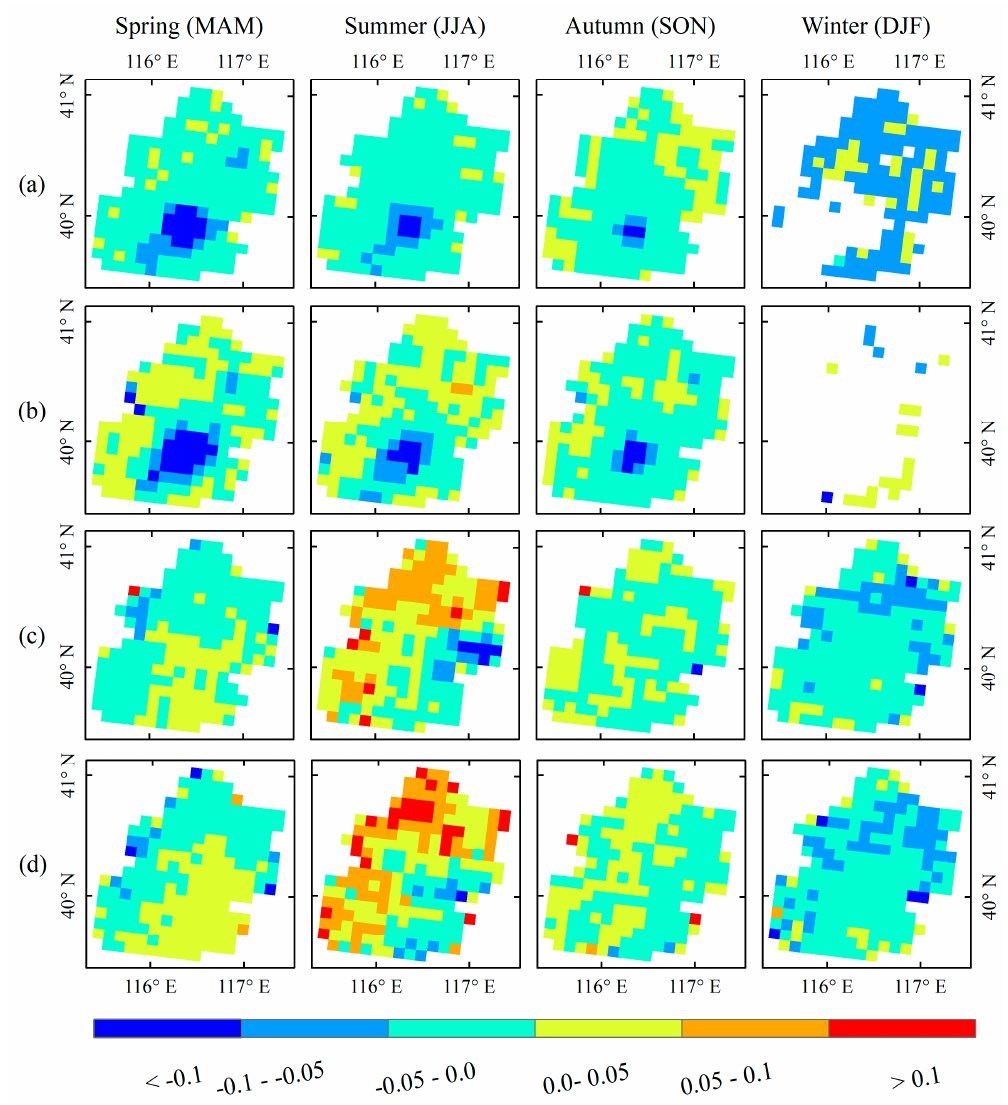
Figure 7. Seasonal mean differences ( δ AER , defined as C6.1_AOD–C6_AOD) of ( a ) MODIS-Terra (MOD04) DT, ( b ) MODIS-Aqua (MYD04) DT, ( c ) MOD04 DB, and ( d ) MYD04 DB AOD retrievals over Beijing. The MOD04 and MYD04 products were obtained from January 2001 to December 2016 and from July 2002 to December 2016, respectively.